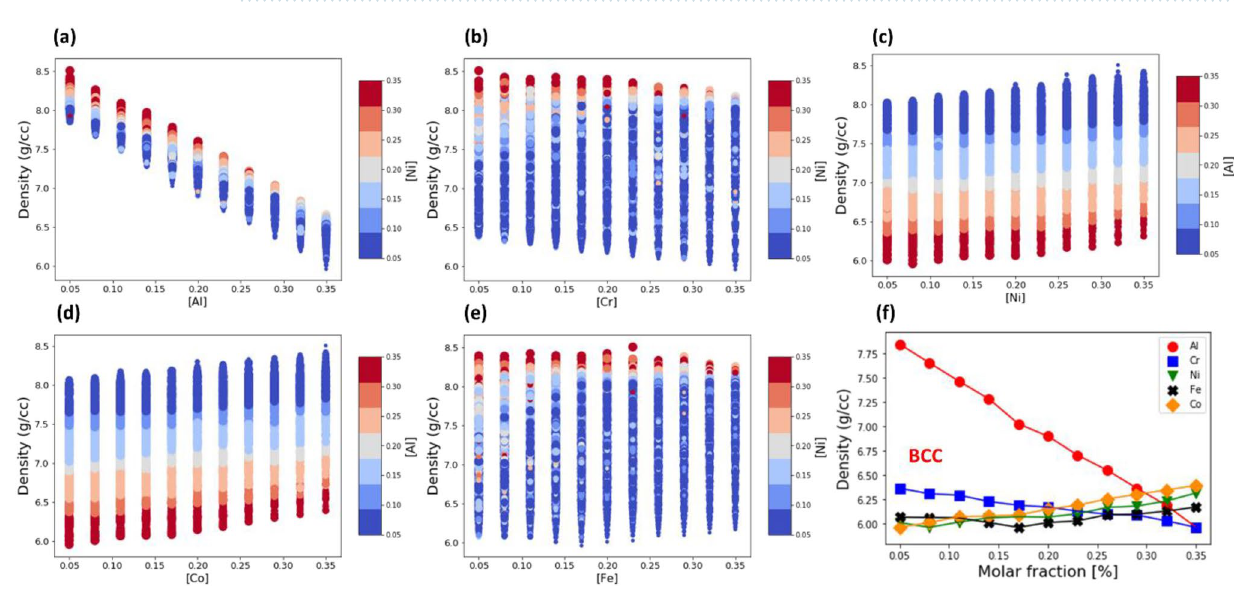
Figure 4. The effect of molar fraction of constituent elements on the density of BCC AlCoCrFeNi HEA. The density is plotted vs. the molar fraction of Al ( a ), Cr ( b ), Ni ( c ), Co ( d ) and Fe ( e ). For a given HEA composition, marker color indicates the molar fraction of Ni in ( a ), ( b ), ( e ) and Al in ( c ), ( d ). Marker size is proportional to the molar fraction of Co in ( a ), ( b ), ( e ) and Cr in ( c ), ( d ). ( f ) The density minimum of AlCoCrFeNi HEA with BCC lattice as a function of molar fraction of constituent elements: Al (red circles), Cr (blue squares), Ni (green triangles), Fe (black crosses) and Co (orange